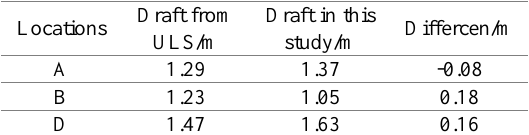
Table 2. Statistics of differences between ULS and CryoSat-2